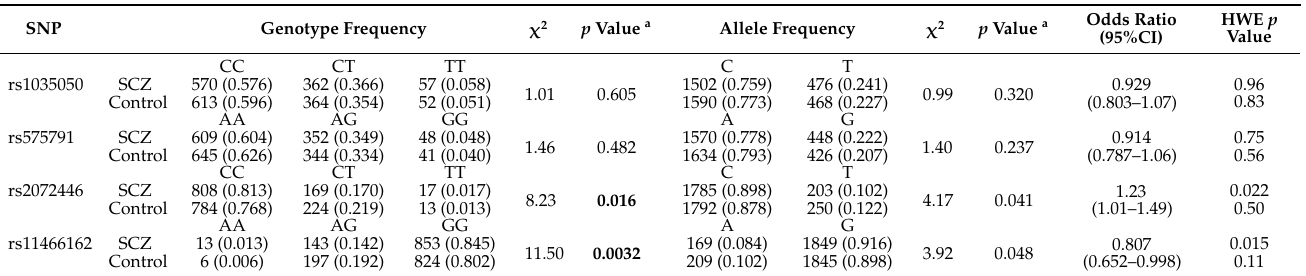
Table 3. Allele and genotype distribution of NGFR gene polymorphisms between SCZ patients and healthy